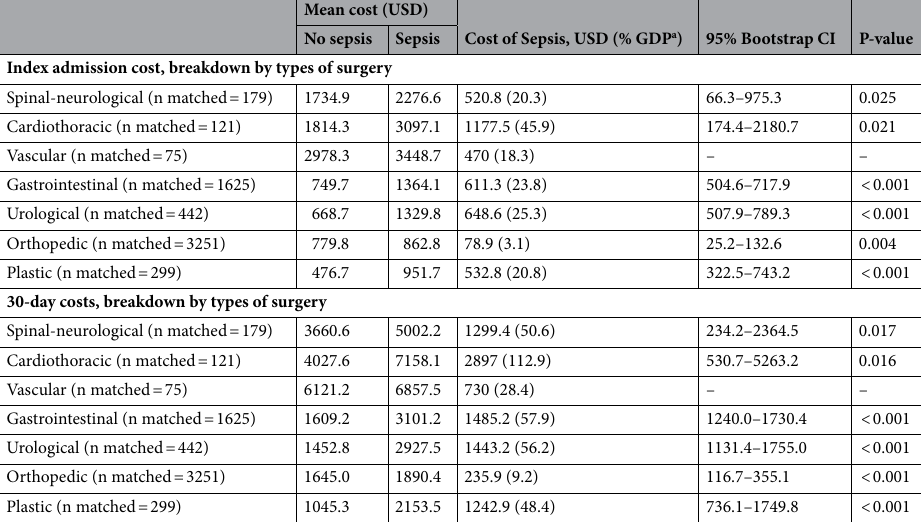
Table 3 shows the incremental cost of sepsis complications by type of surgery. The highest incremental cost was found in patients undergoing cardiothoracic surgery, at 1,177.5 USD (95% CI 174.4–2180.7) for the index